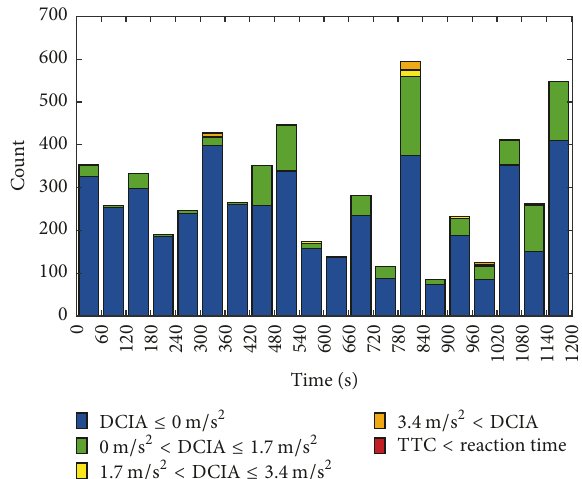
Figure 11: MDRAC values calculated with PRT = 2.02 s categorized in four groups over the considered time interval in lane 2.